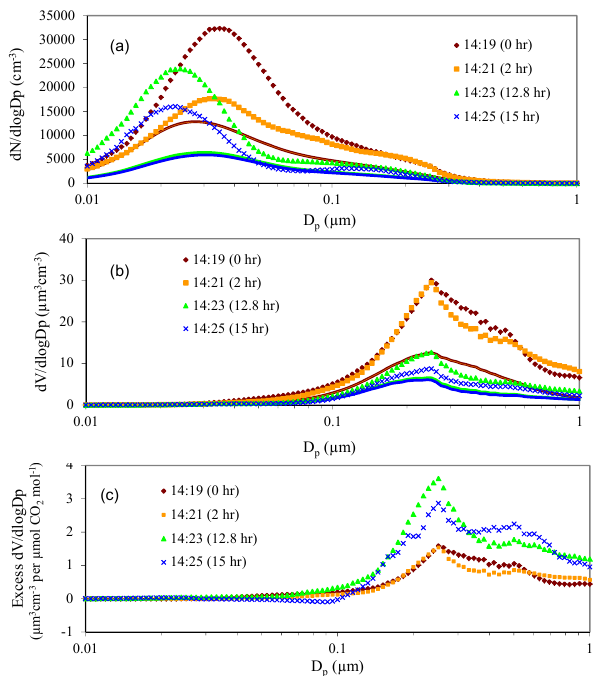
Figure 11. Measured number and volume distributions in the DC-8 plume near Mexico City during the March 11, 2006 flight at average altitude of 342 m above ground at 14:20 local time. Panel (a) shows measured number size distributions (symbols) with calculated size distributions (lines) based on a regional background plus the primary emission factor (this work) times the CO 2 increment above background. Panel (b) shows the same as (a) except number size distributions have been converted to volume distribution. Panel (c) shows the difference between measurement and background + primary, normalized to the CO 2 increment in the plume. Photochemical ages, calculated using the benzene/toluene ratio relative to the ratio at 14:19, are shown by each distribution. Integrals of the volume distributions through 2 microns in (c) are 0.96±0.16, 0.97±0.17, 2.1±1.1, and 1.8±2.1 µm 3 cm -3 per ppm. For reference, the primary emission factor (through 2 microns) is 0.49 µm 3 cm -3 per ppm.